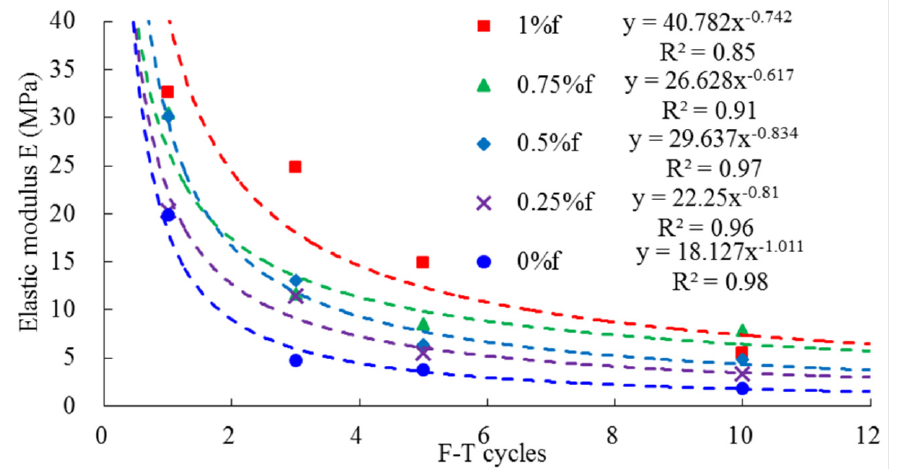
Figure 8. Elastic modulus of the FCMS under F–T